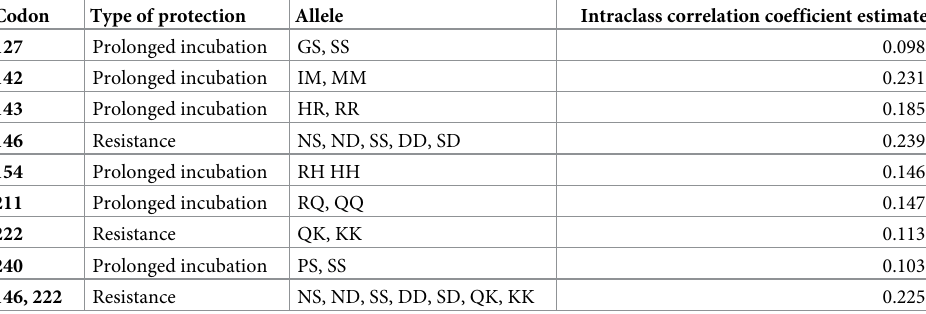
Table 3. Intraclass correlation coefficients (ICC) estimated at the goat operation level, by